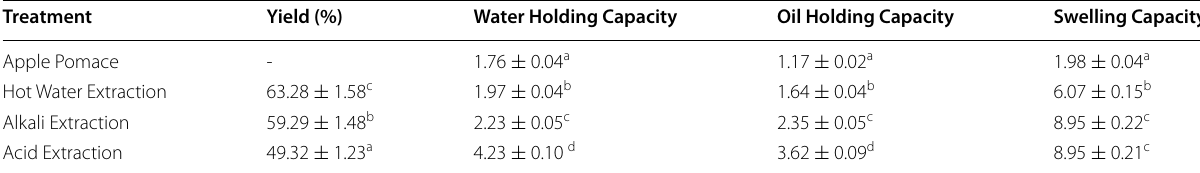
Table 1 Total yield and functional characteristics of apple pomace and extracted dietary fiber fractions